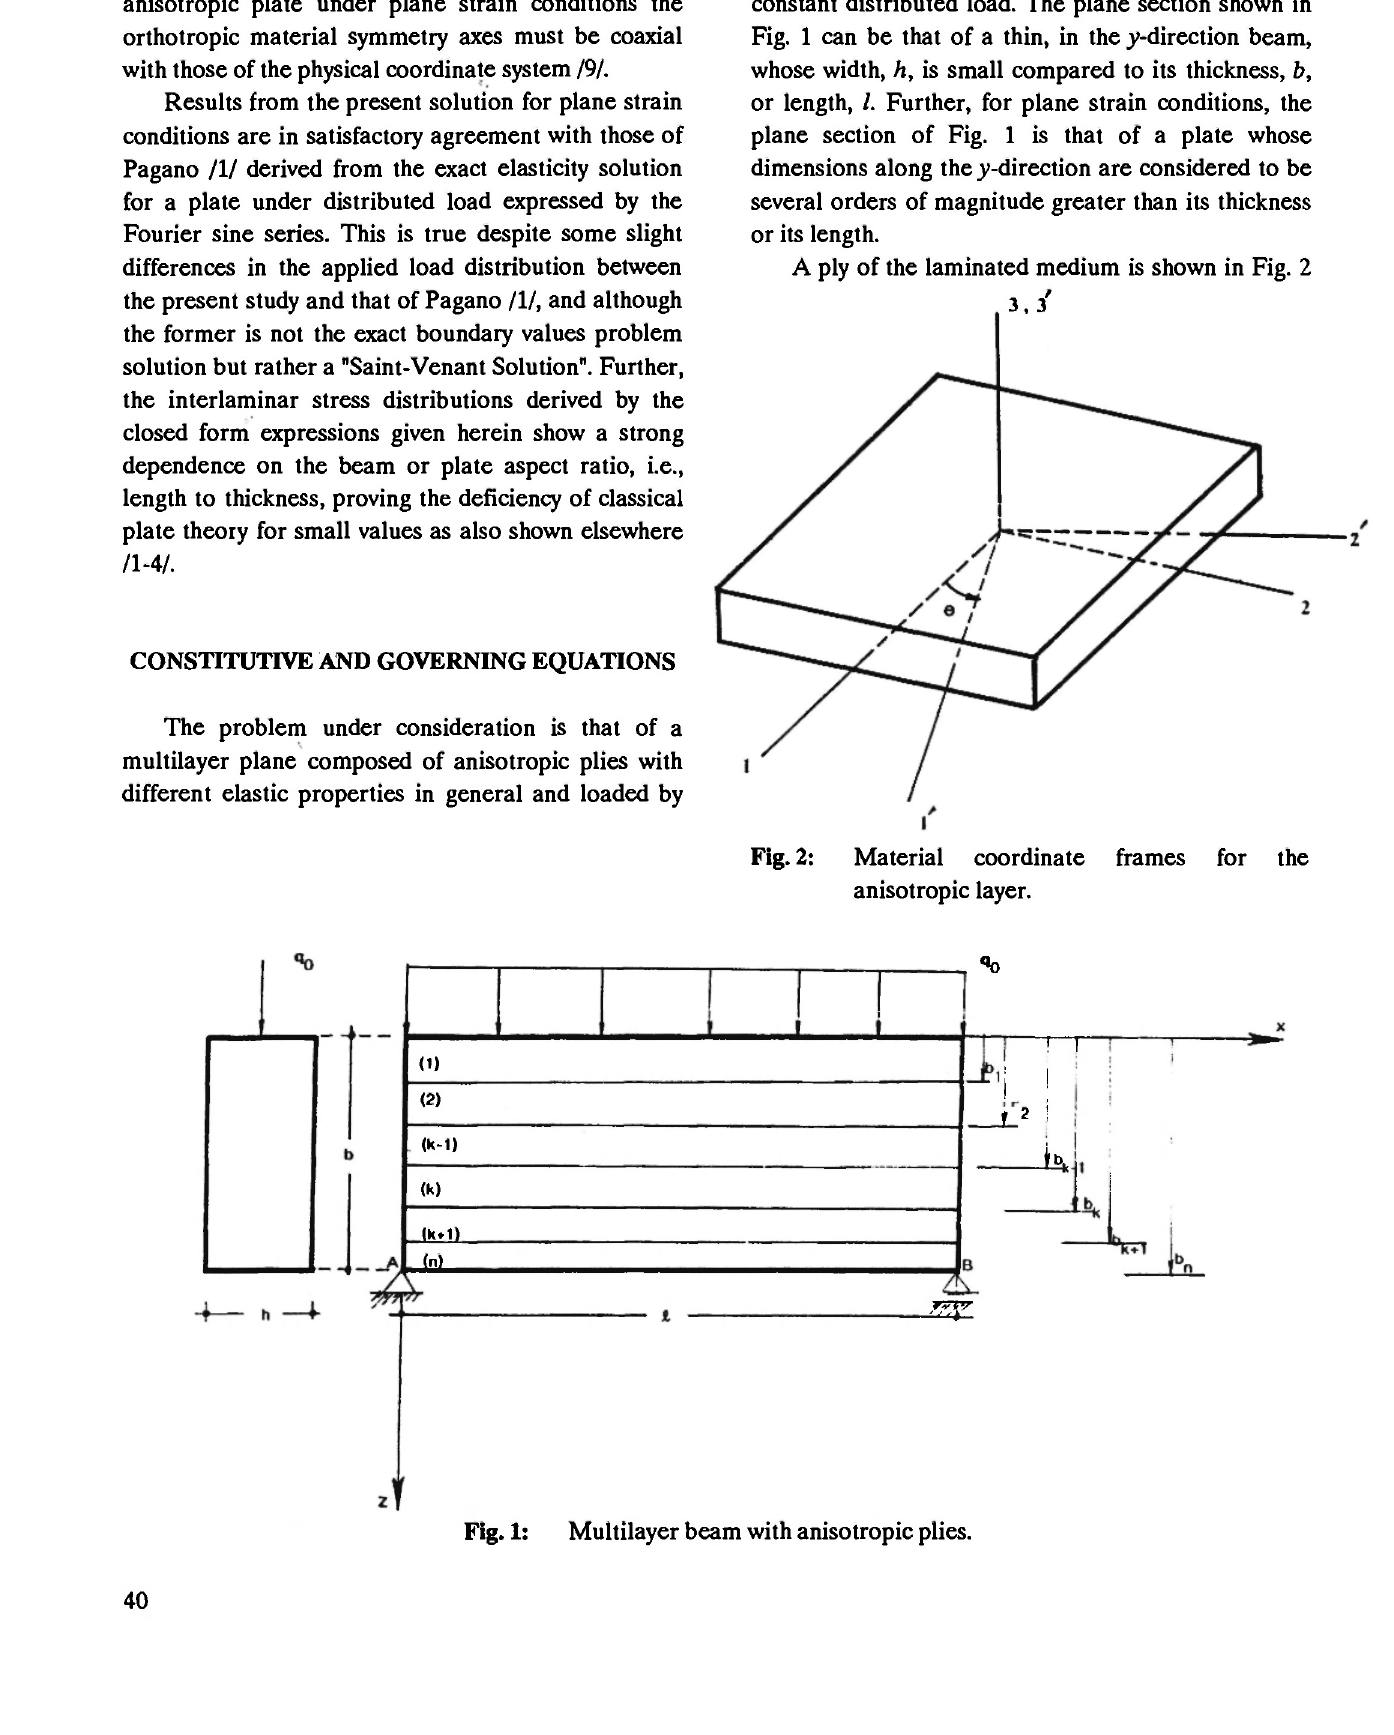
Fig. 1: Multilayer beam with anisotropic